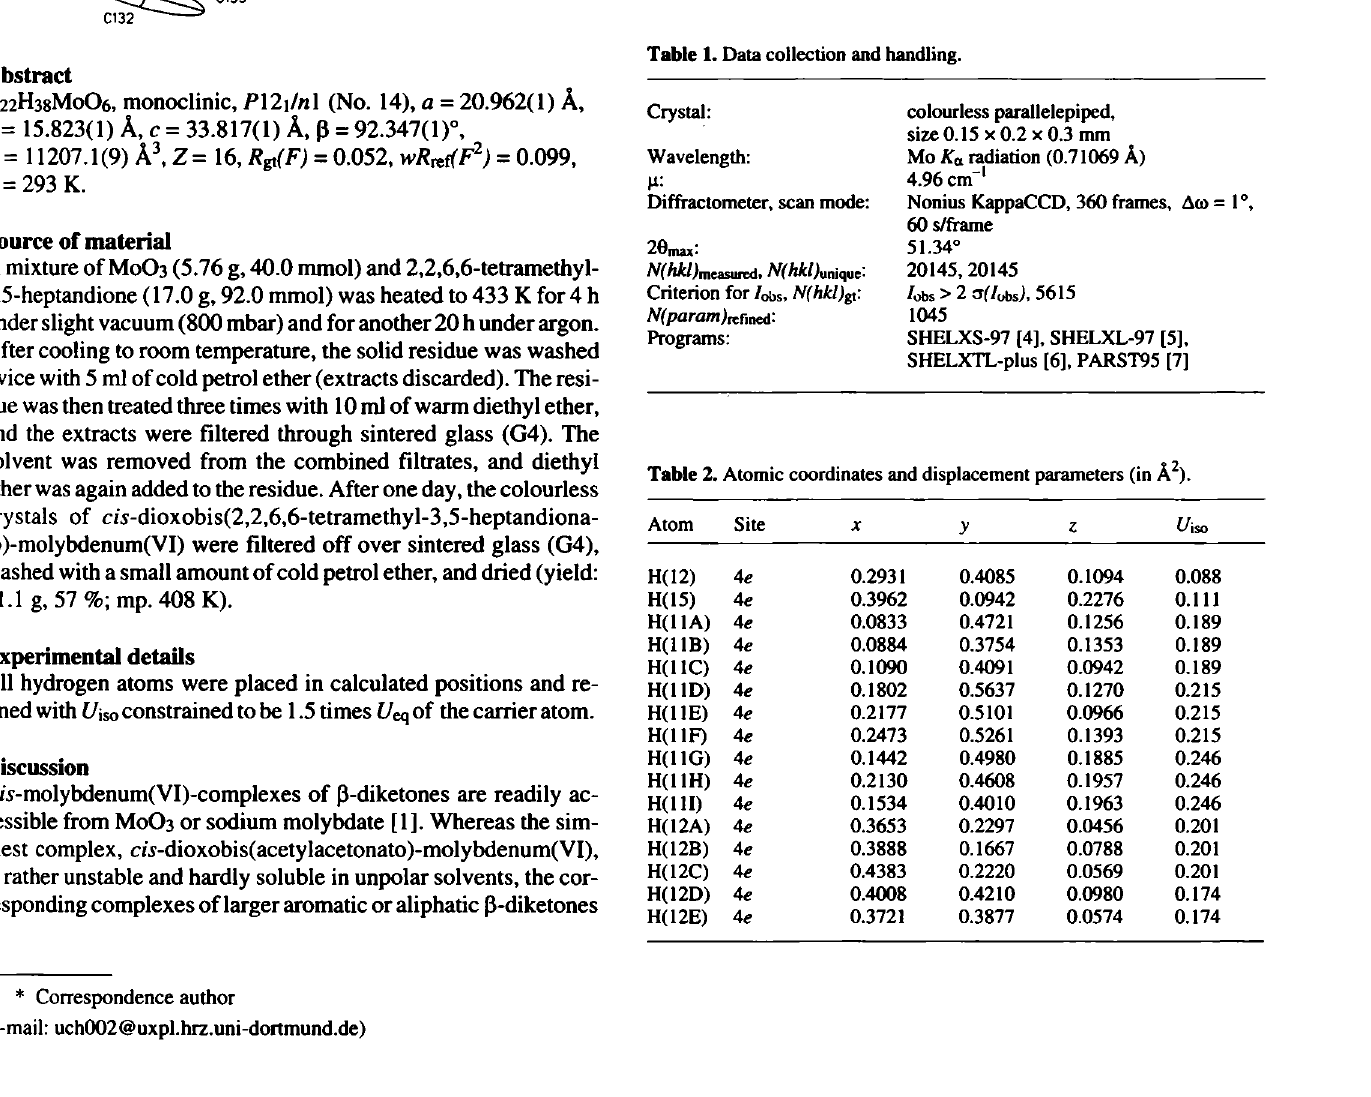
Table 1. Data collection and handling.